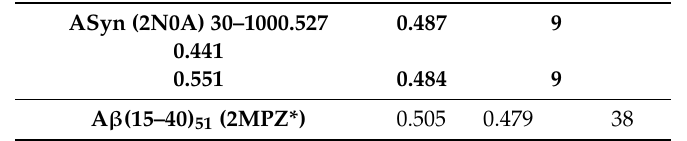
Table 6. Status of a single chain expressing di ff erences between the description using 3D Gauss (3DG) and 2D Gauss (2DG) models. 3DG—for the structure of an individual chain in the 3D Gauss representation, 3DG*—RD values for determining the status of the chain treated as a component of the entire protofibril, 2DG—status for the 2D Gauss representation. RDe—RD values obtained after eliminating the residues listed in the right column. The residues that are di ff erent for the two compared forms of description are